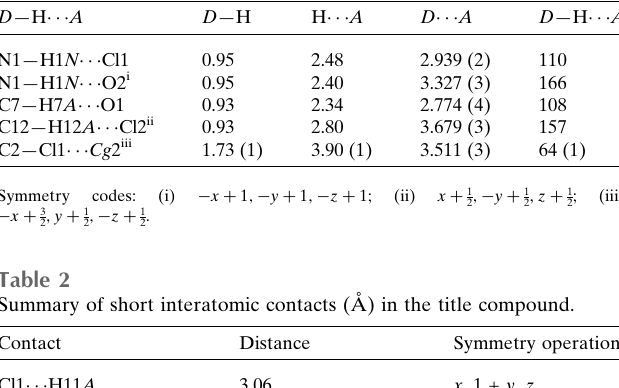
of the title compound.